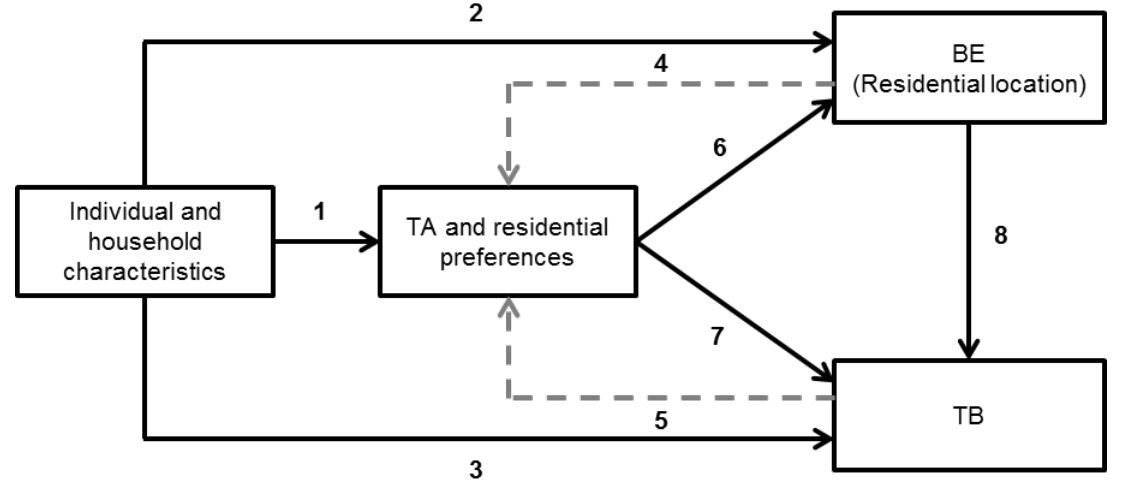
Figure 1. Conceptual model of relationships between BE-TB and intervening variables. Adjusted from Bohte